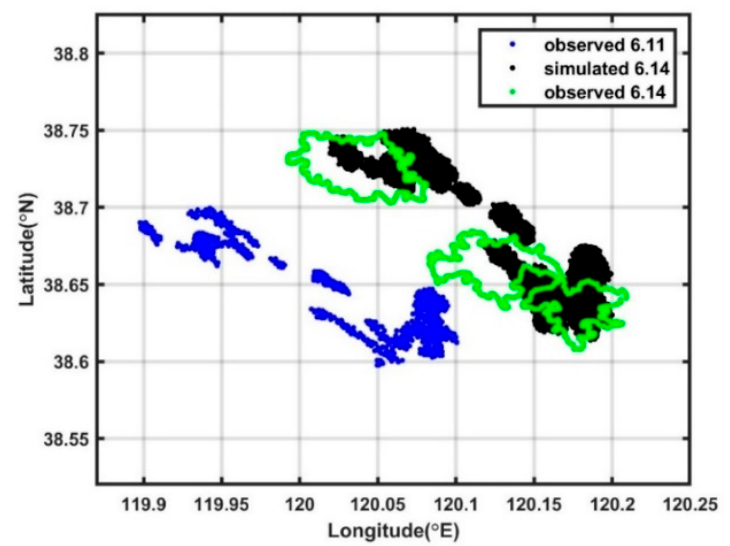
Figure 2. Distribution of oil slick at the sea surface observed on June 11 (blue dots) and June 14 (green dots), and the simulated result for June 14 (black dots).